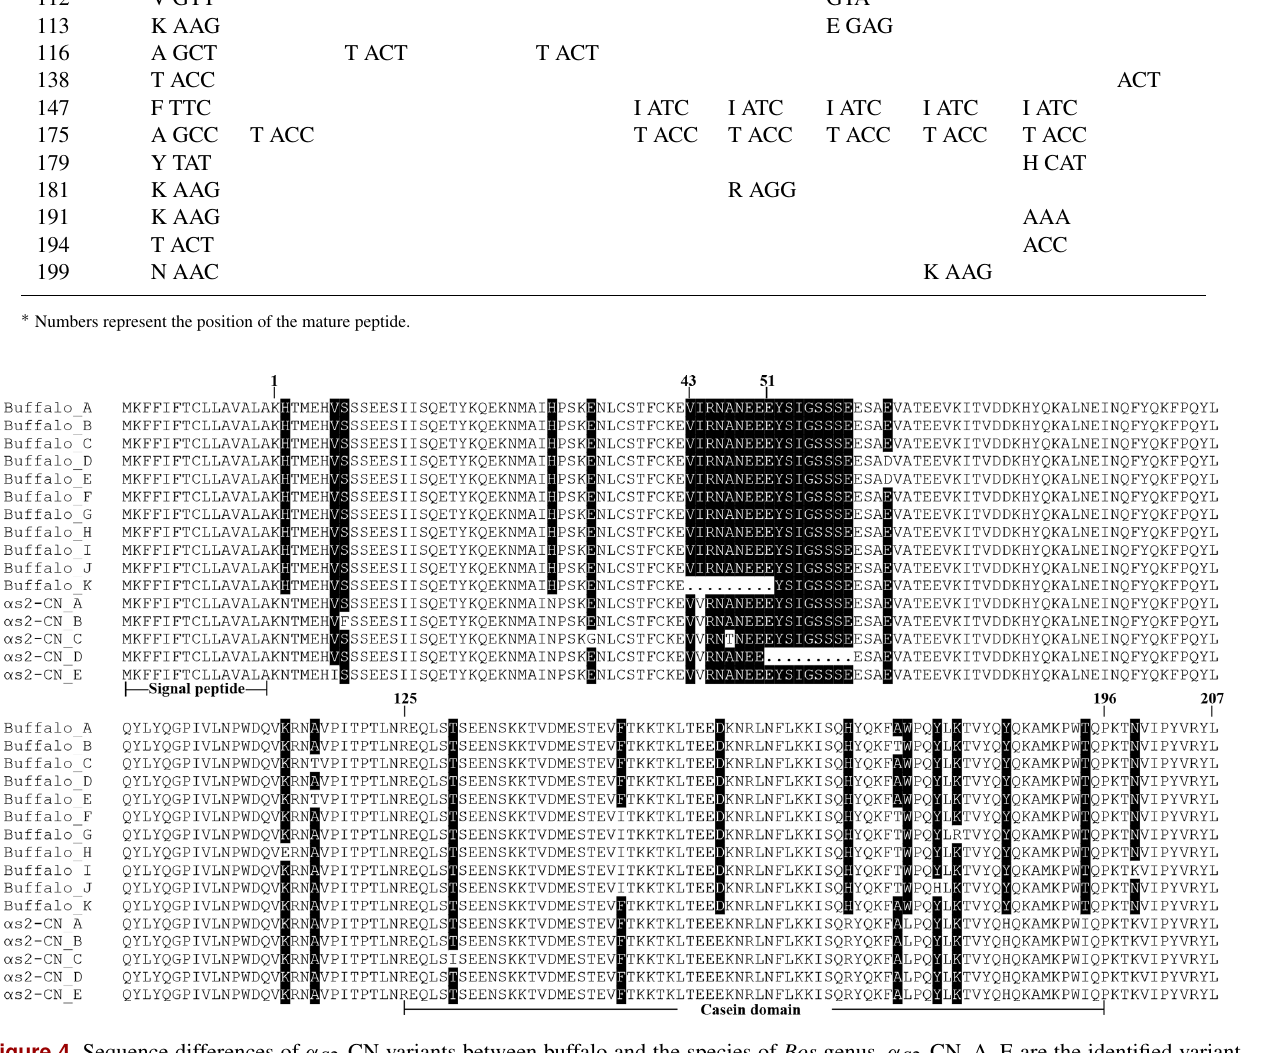
Figure 4. Sequence differences of α S 2 -CN variants between buffalo and the species of Bos genus. α S 2 -CN_A–E are the identified variant sequences in the Bos genus. Dots (.) represent the deletion in the sequences. Amino acid differences are denoted by black